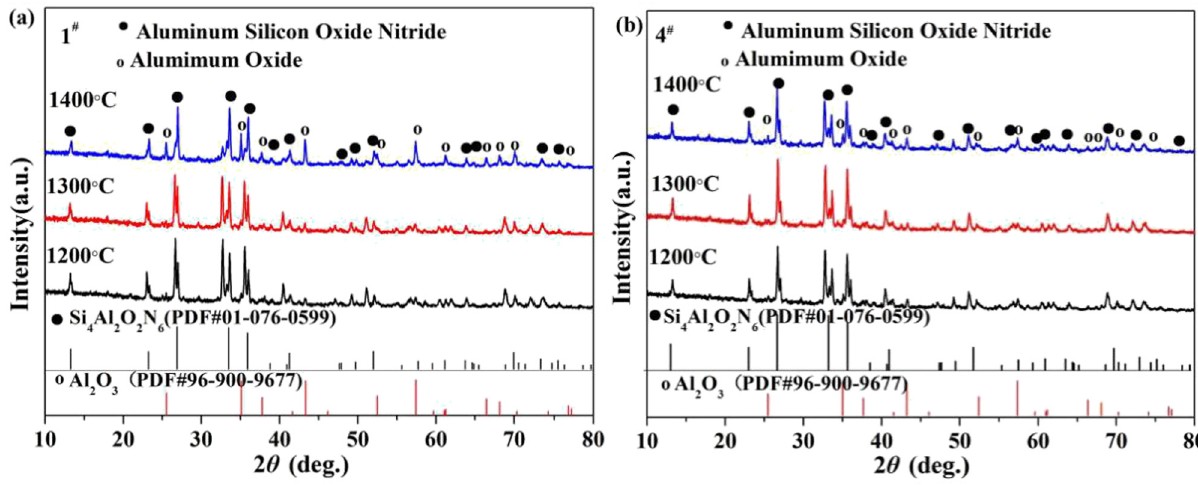
Figure 9: XRD patterns of the samples oxidized under different temperatures for ( a ) specimen 1 # and ( b ) specimen 4 # .